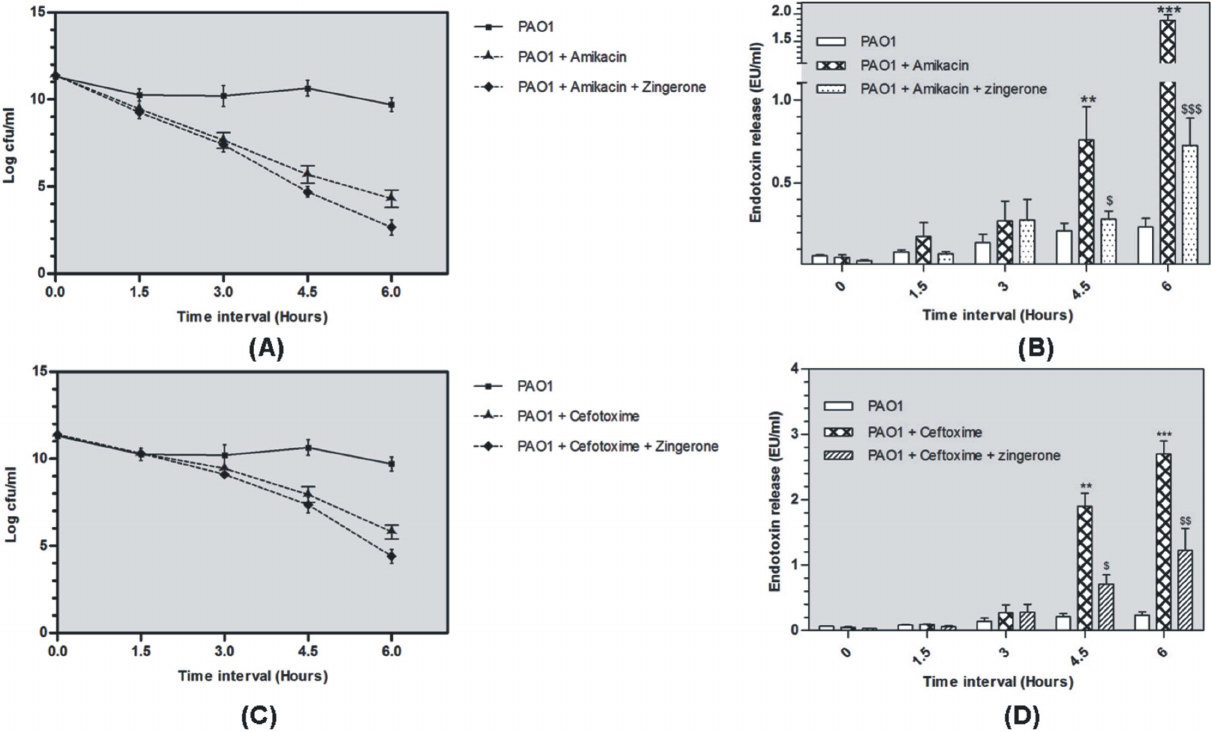
Figure 3. Invivo bacterial killing and endotoxin release potential of antibiotics against P.aeruginosa PAO1 [bacterial killing curve Fig.3 (amikacin-A, cefotaxime-C) and endotoxin release (Fig.3- amikacin-B, cefotaxime-D)] ( $ , * p , 0.01, $$ , ** p , 0.01 and ***, $$$ p , 0.001) (*indicates comparison between infection control and antibiotic alone groups and $ indicates comparison between antibiotic alone and antibiotic-zingerone treated groups).